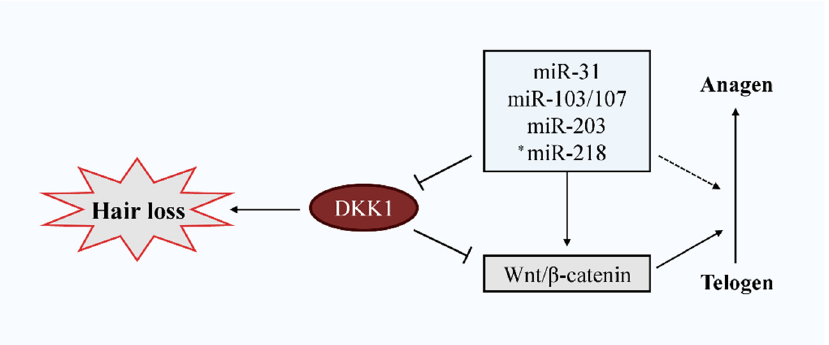
Figure 4. Illustration of potential implication of miRNAs on telogen to anagen transition. miR-31, miR-103/107, miR-203, and miR-218 regulate DKK1 levels and activate the Wnt/ β -catenin signaling pathway, which influences telogen to anagen transition. Abbreviations: DKK1, dickkopf-related protein 1. * Indirect inhibition of DKK1 [153].